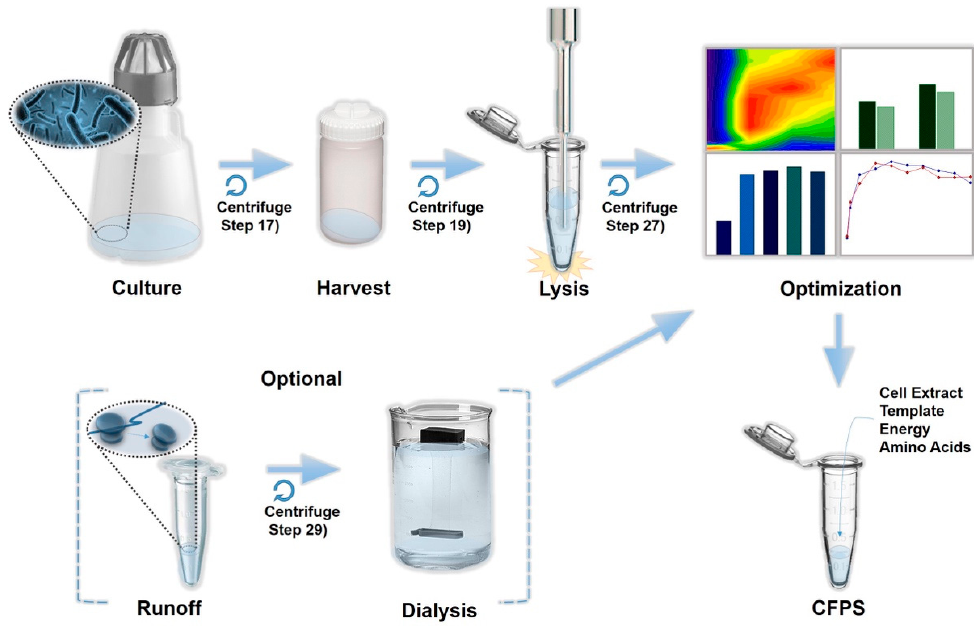
Figure 1. A workflow of the cell extract preparation and optimization.